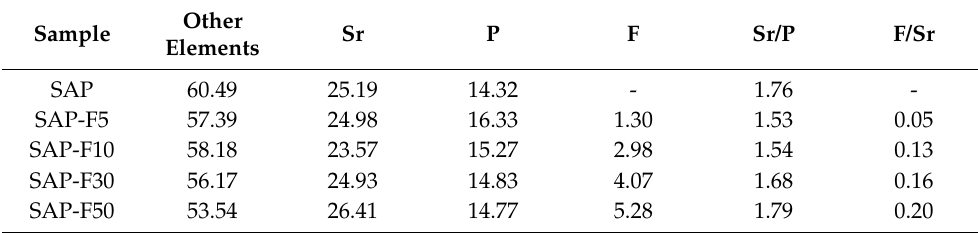
Figure 5. EDX analysis graphics of synthesized nanoparticle. Table 2. EDX analysis results of fabricated nanoparticles